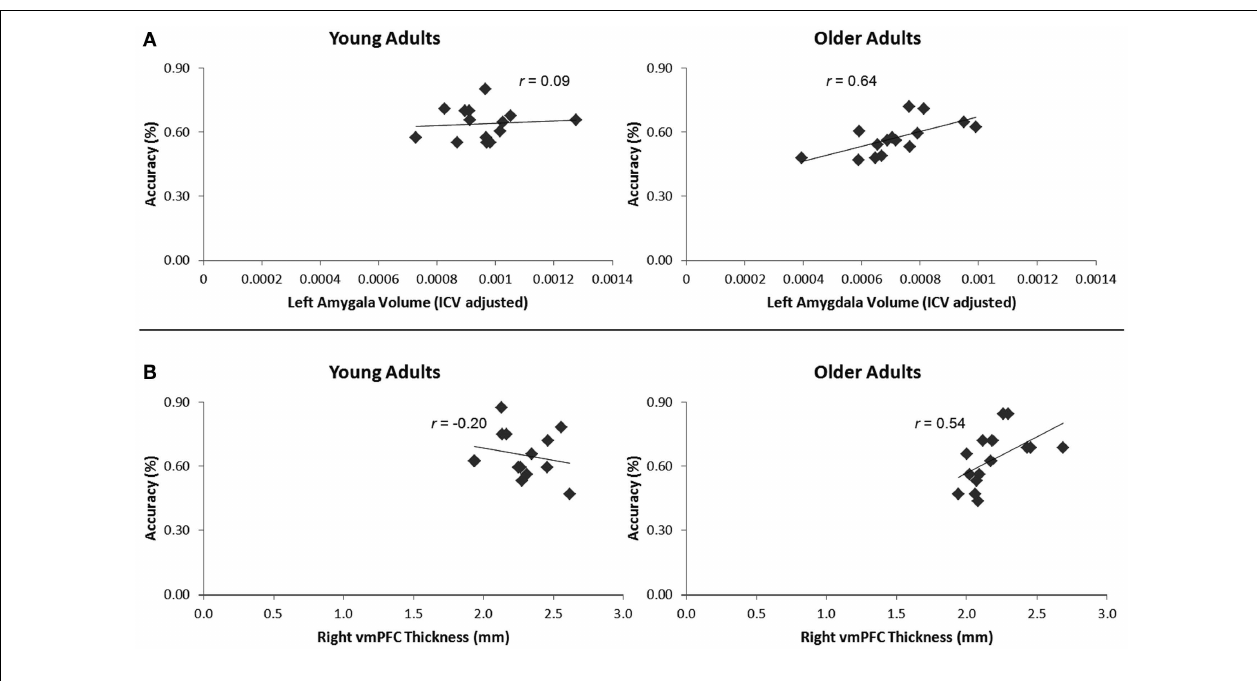
thickness corresponded with enhanced memory for impressions formed when making the social-meaningful evaluations in older, but not younger